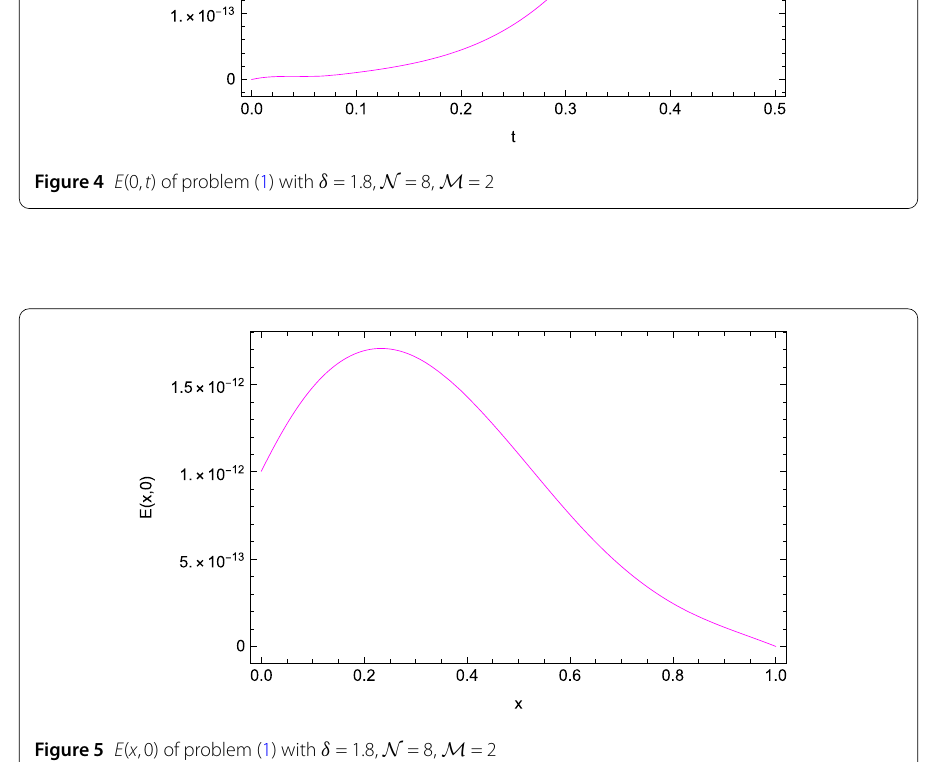
Figure 5 E ( x ,0) of problem (1) with δ = 1.8, N = 8, M =